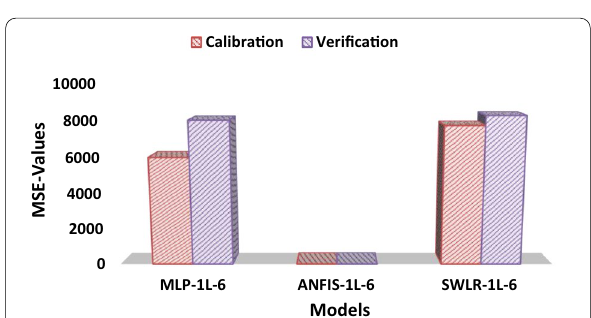
Fig. 4 Comparative MSE values of the models in modelling 1L-6 inflammatory